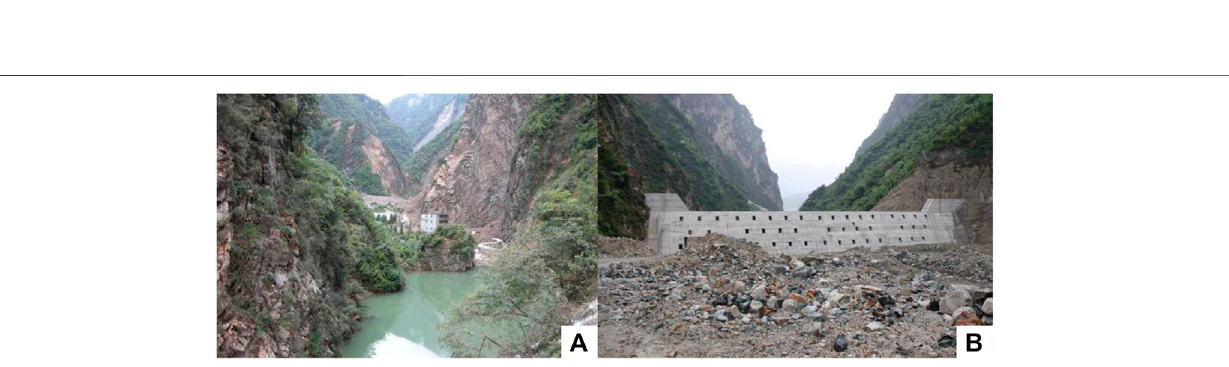
Frontiers in Earth Science |